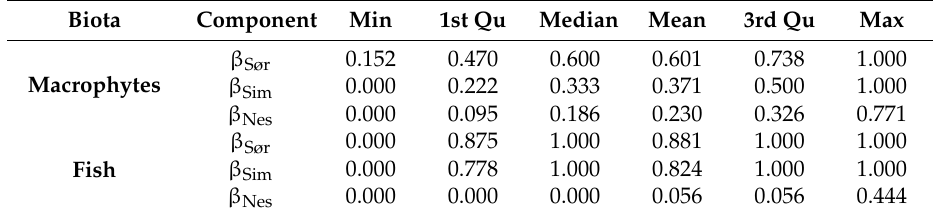
and nestedness dissimilarity ( β Nes ) for macrophytes and fish in the studied lakes.